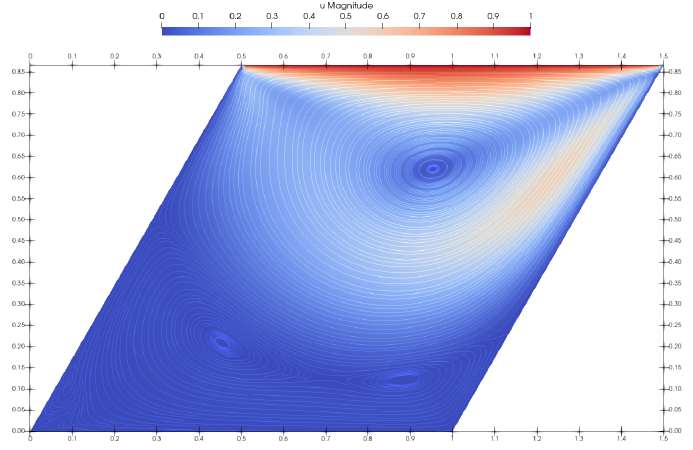
Figure 5. Velocity magnitude and streamlines for Power Law fluid flow in the skewed cavity, for Re = 500 and n = 1.5.